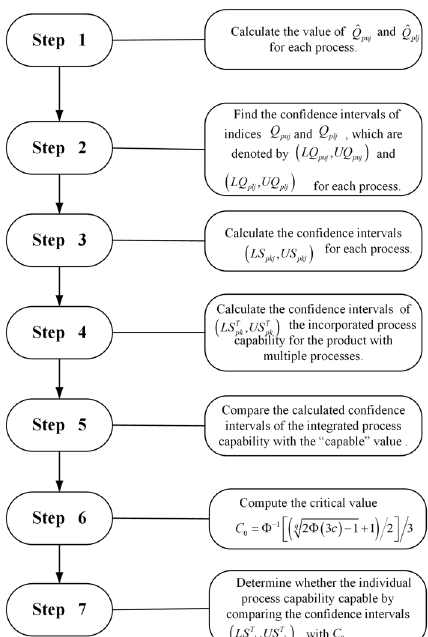
Figure 1. Evaluation procedure steps